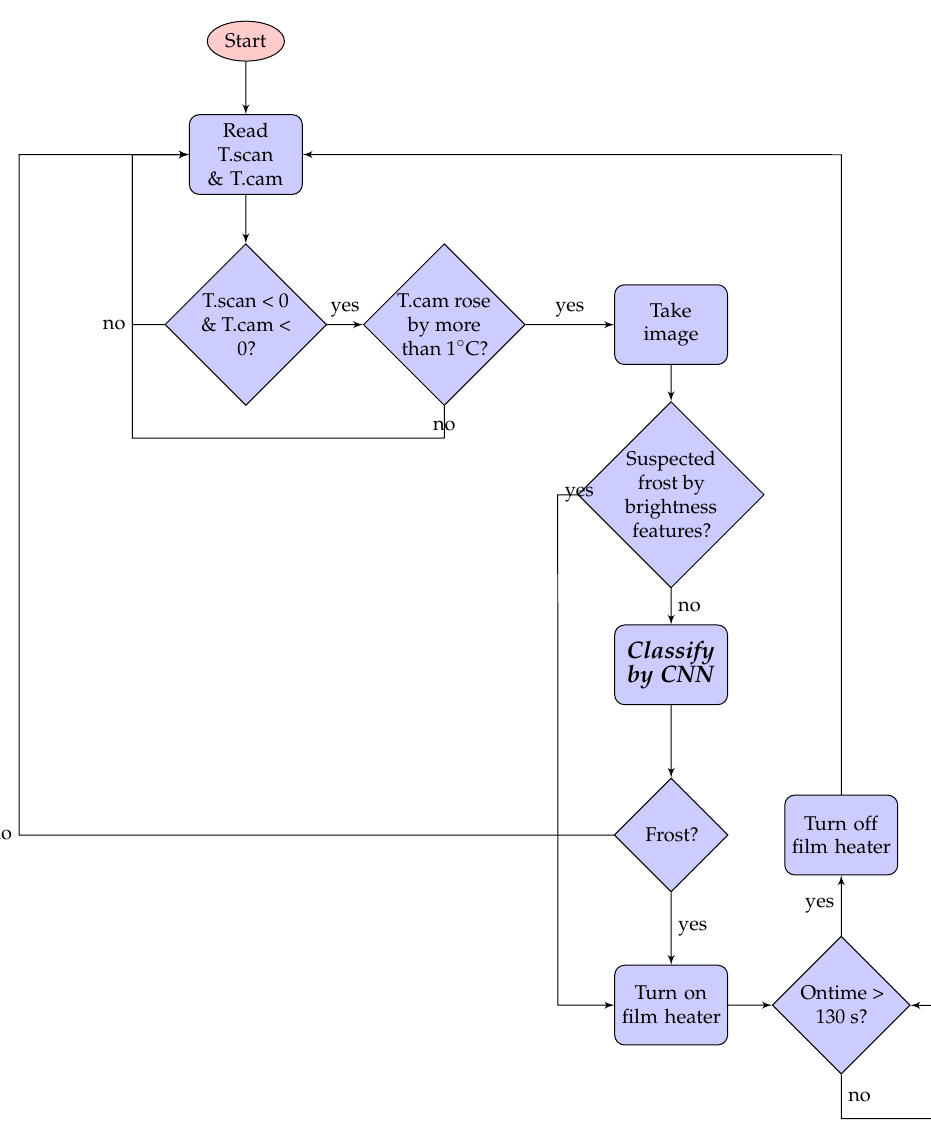
Figure 12. Proposed edge AI